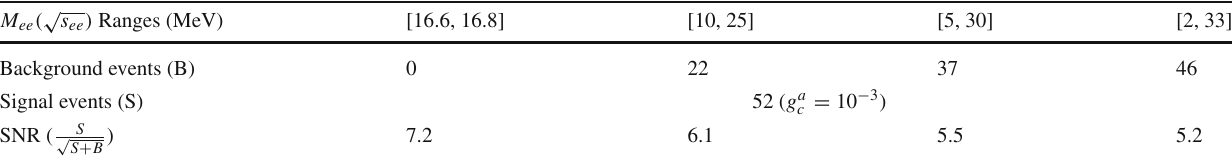
Table 2 The signal-to-noise ratios (SNR) around the X resonance mass (16.7 MeV), where we adopt four invariant-mass ranges for the background process. Note, signal events would be suppressed by two orders of magnitude when taking g a c = 10 − 4 √ M ee ( s ee ) Ranges